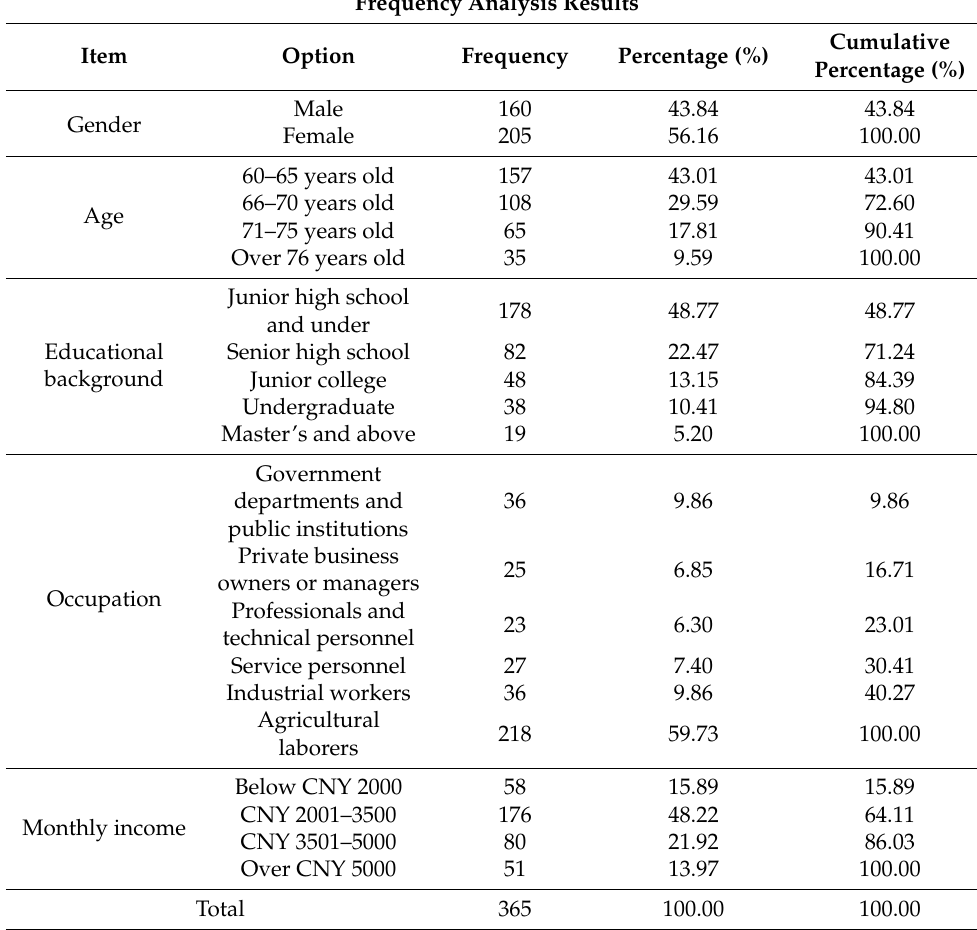
Table 2. Basic information of